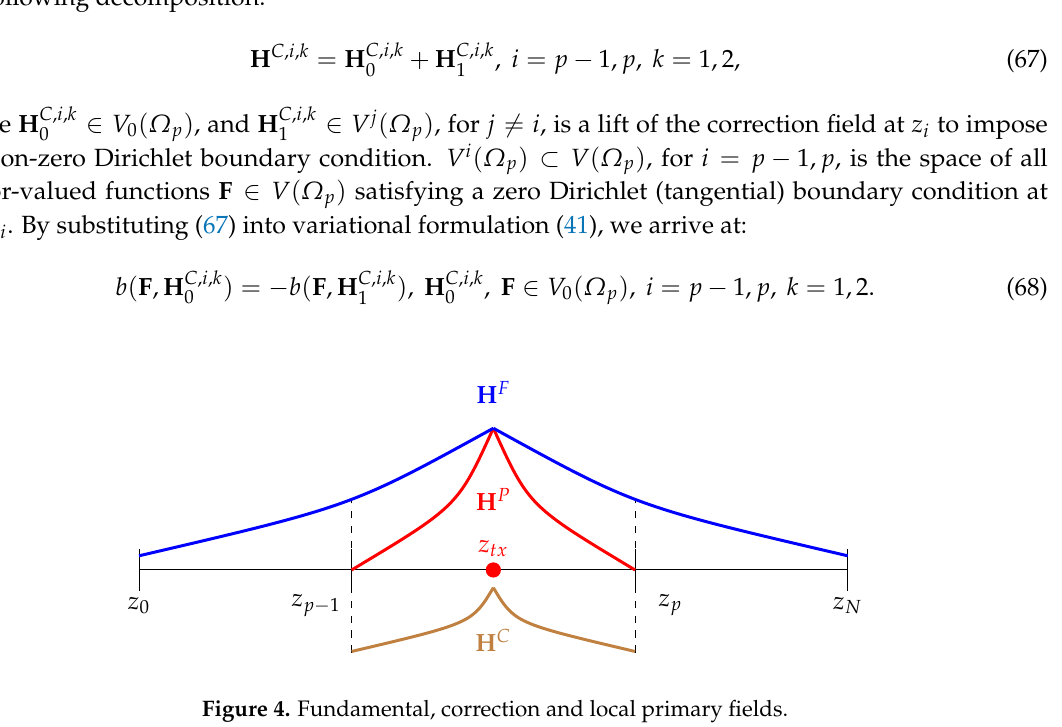
Figure 4. Fundamental, correction and local primary